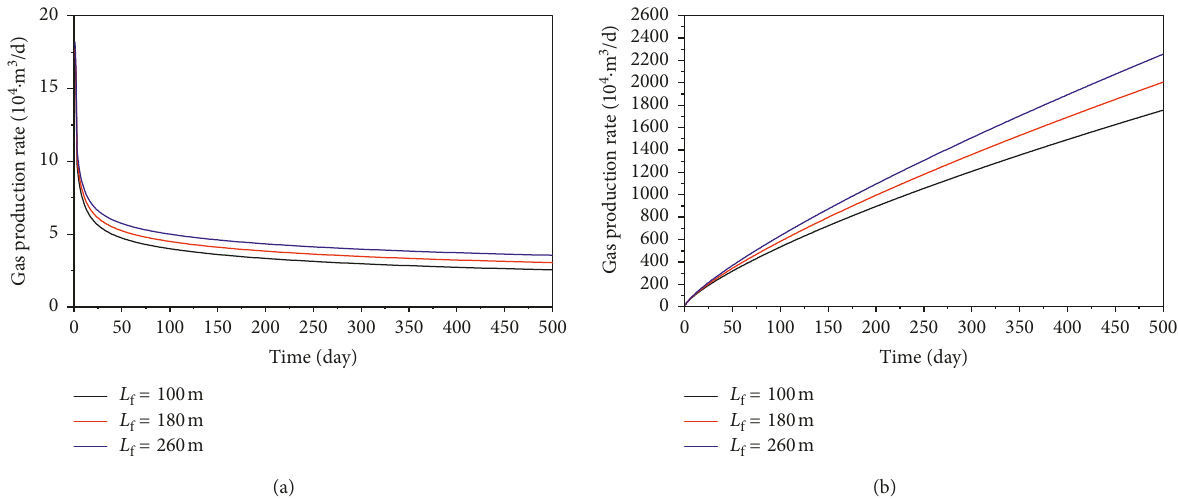
Figure 19: Effect of fracture length on behavior of the multistage fractured horizontal well: (a) gas production rate; (b) cumulative gas production.